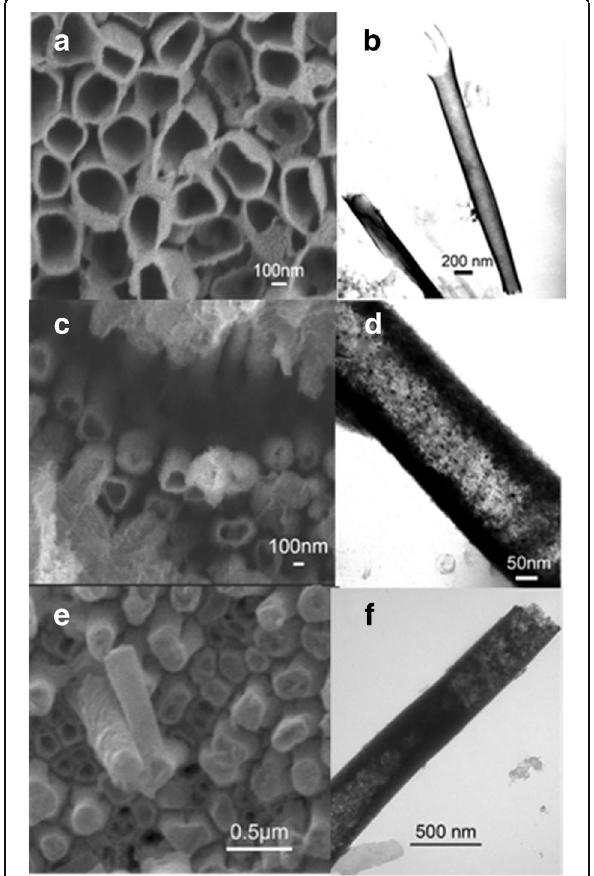
Fig. 2 SEM images: a Ni/PA66, c Co/PA66, e Fe/PA66; TEM images: b Ni/PA66, d Co/PA66, and f